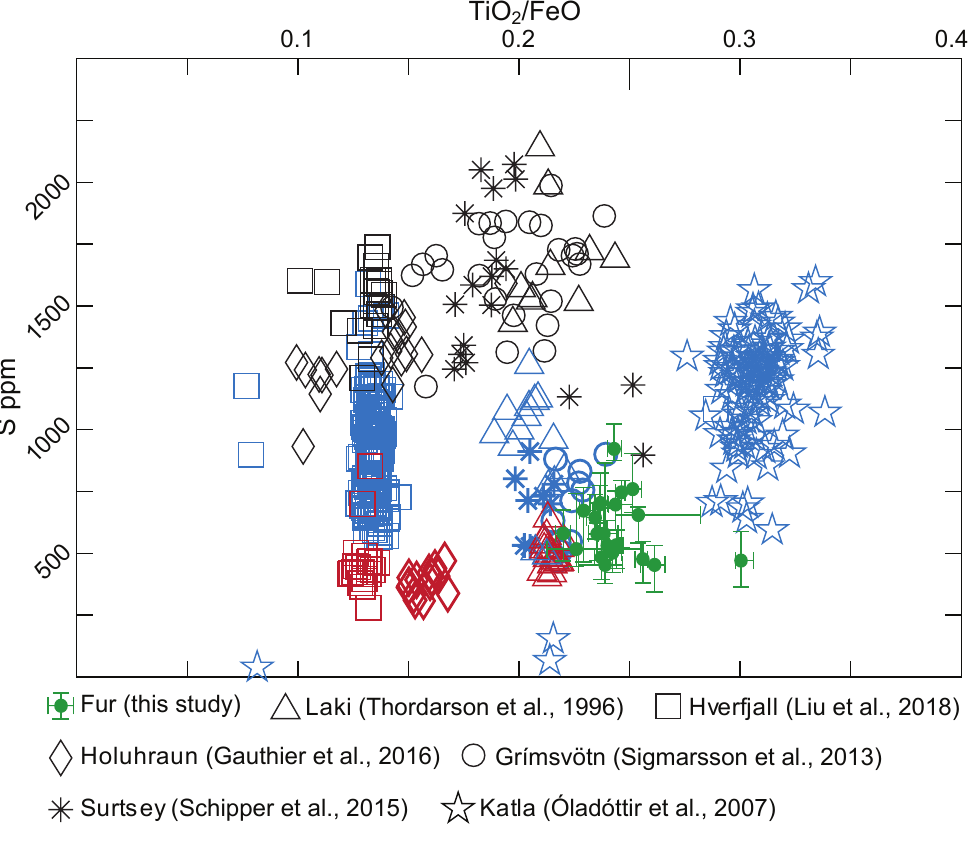
Figure 13: Compilation of sulfur concentrations in Icelandic basalts as a function of TiO 2 /FeO. Di ff erent systems are represented, with melt inclusions in black, magmatic matric glass in red, and hydromagmatic matrix glass in blue. Fur ashes are shown as green